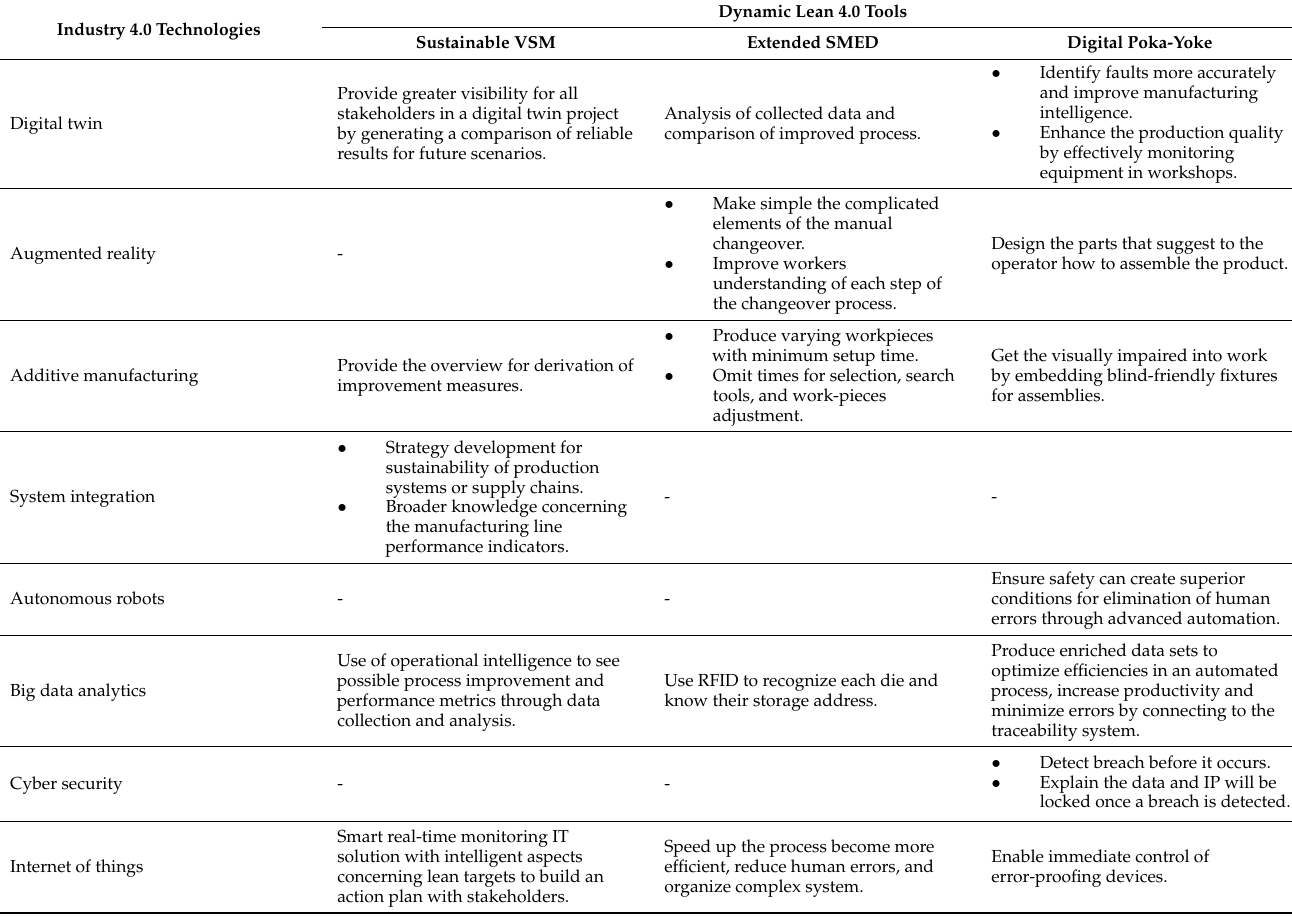
Table 1. Dynamic Lean 4.0 tools and its